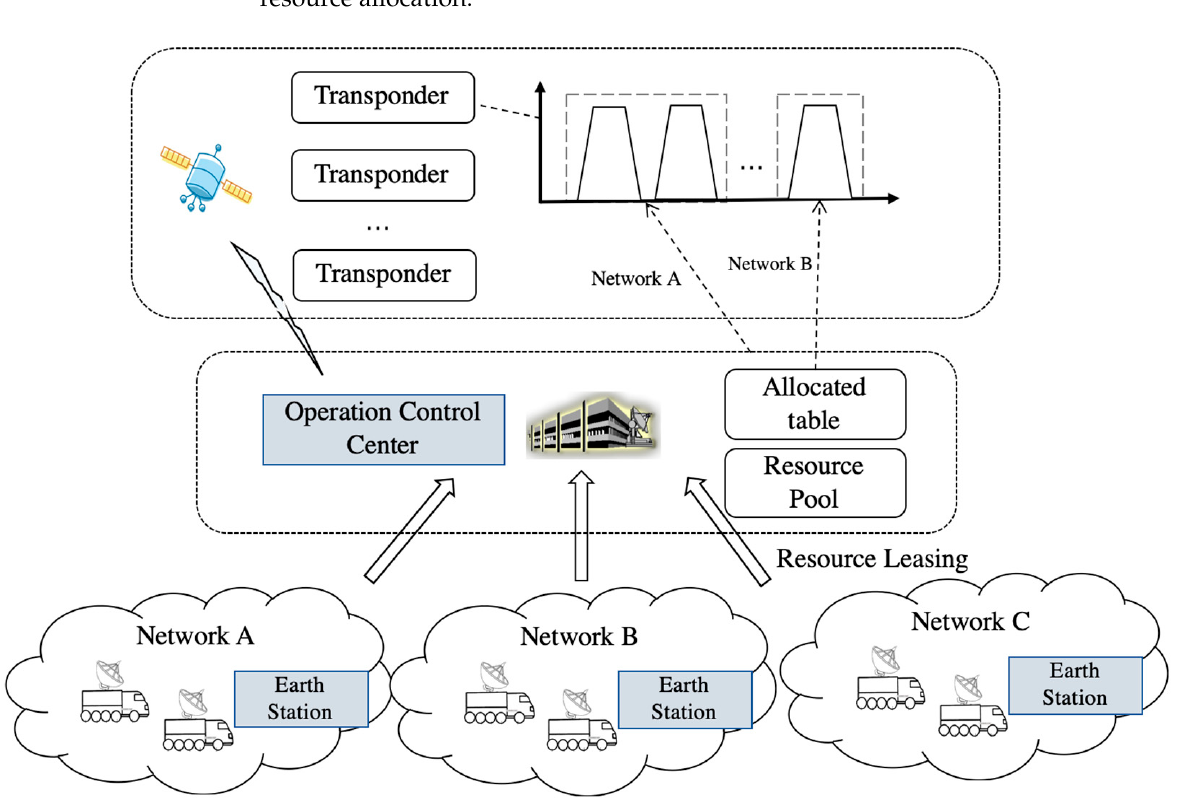
Figure 1. The process of transparent satellite transponder resource allocation.